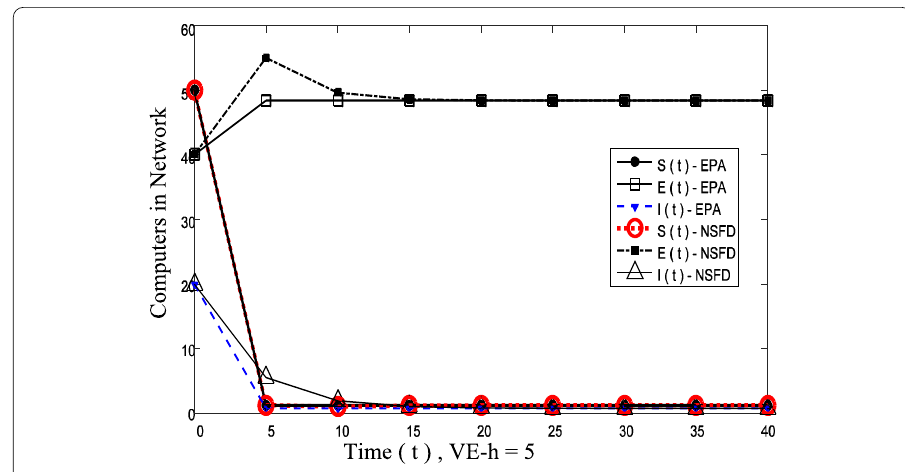
Figure 5 Convergence curves of EPA and NSFDE to VE point for h = 5